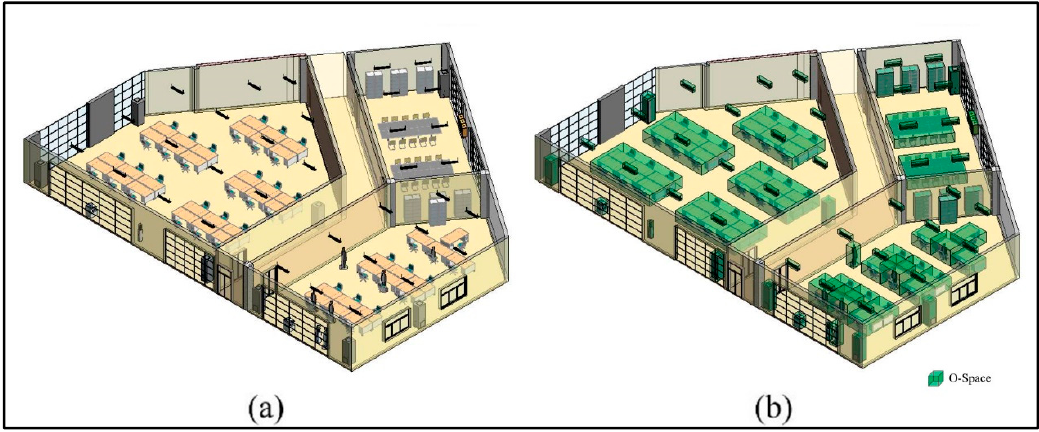
Figure 10. The layout of the experimental environment. ( a ) Actual indoor environment. ( b ) Simplified indoor environment.